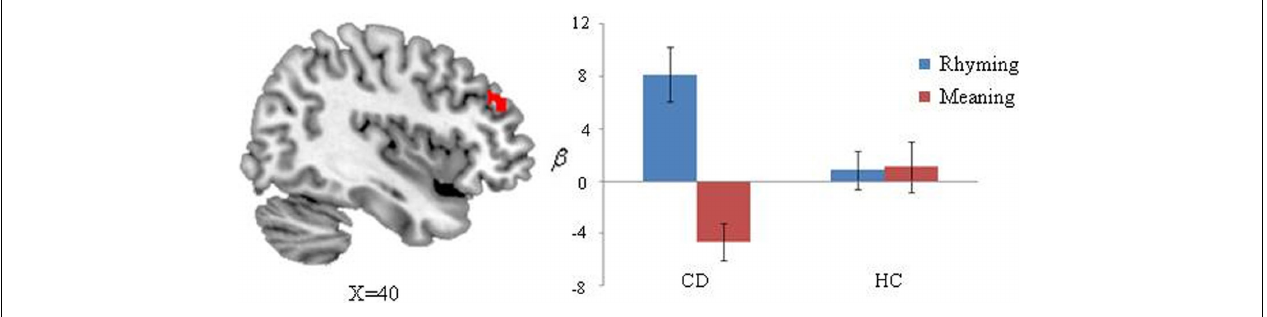
FIGURE 3 | Task differences selective to the congenitally deaf individuals (CD) compared to hearing controls (HC). Bar charts of the right middle frontal gyrus ( x = 38, y = 38, z = 20) is plotted for visualization and shows